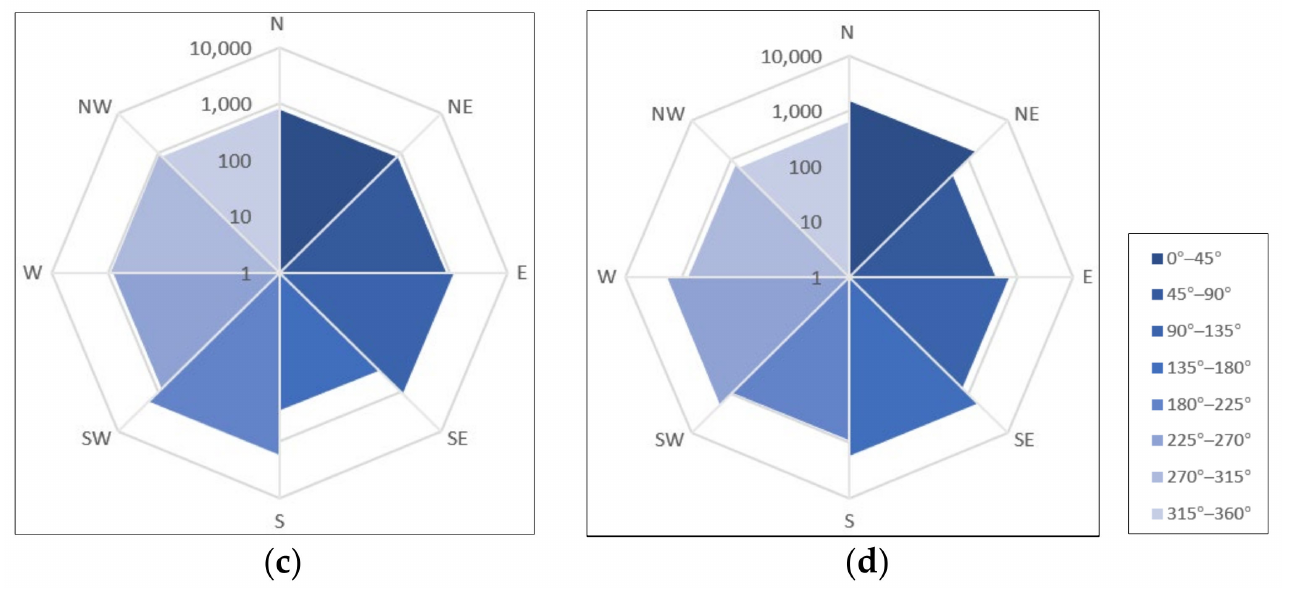
Figure 14. The rose charts of flow direction frequency and accumulative length of the RD. ( a , b ) are the rose chart of the flow directions of units 3 and 7, respectively. ( c , d ) are the rose charts of the accumulative length of units 3 and 7,